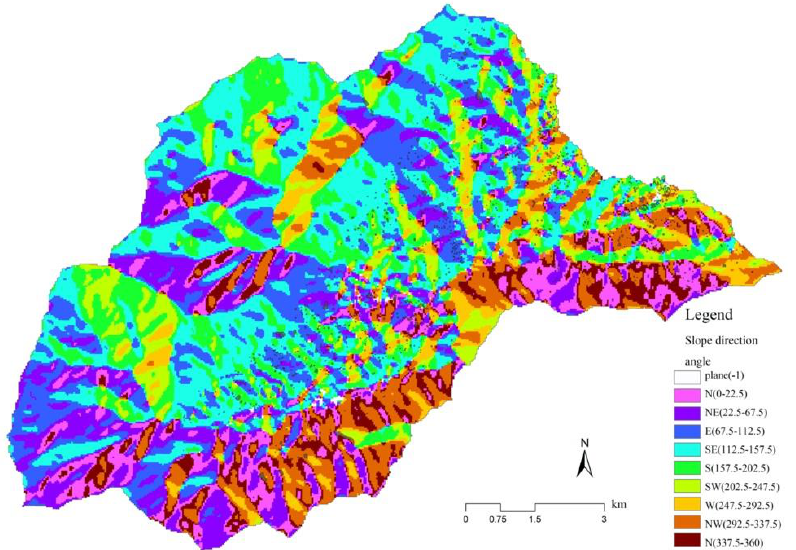
Figure 9. The aspect of the Shangzhuang Basin.